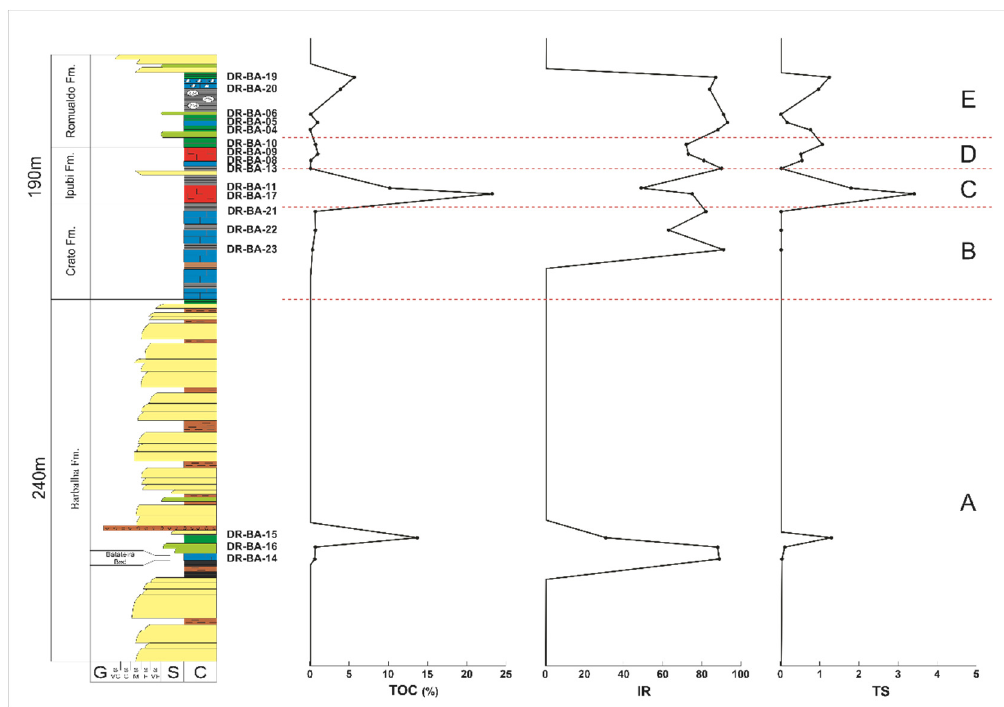
Figure 4. Vertical variation of total organic carbon (TOC), insoluble residue (IR), and total sulfur (TS) from samples of the Santana Group. Five chemostratigraphic units ( A – E ) are highlighted between the dashed lines. See the text for explanation.